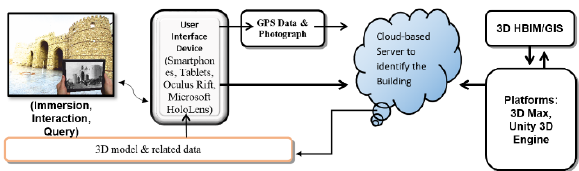
Figure 11. Schematic of the proposed framework for a